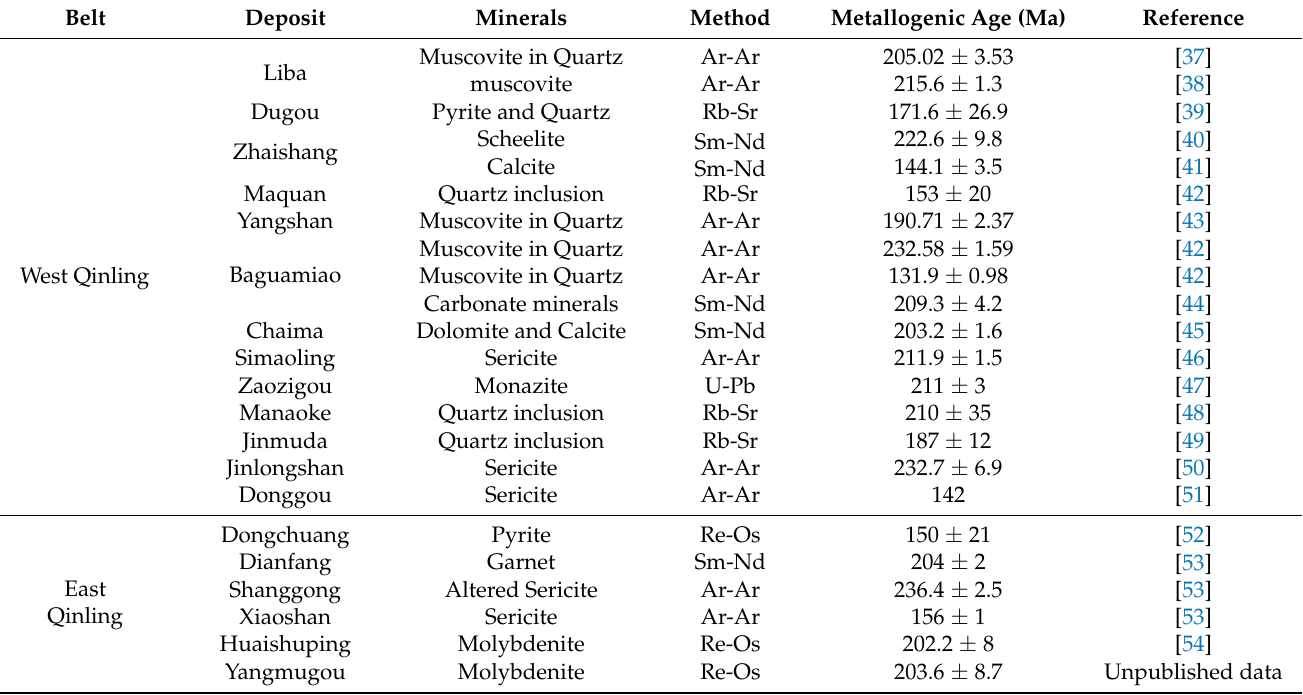
Figure 9. Histogram of metallogenic age of gold deposits in Qinling orogenic belt (See Table 4 for the detail) ( a ) [37–54], and intrusive age of Zhashui-Shanyang area ( b ) [6–13,20]. Table 4. Formation age of gold deposits in Qinling orogenic